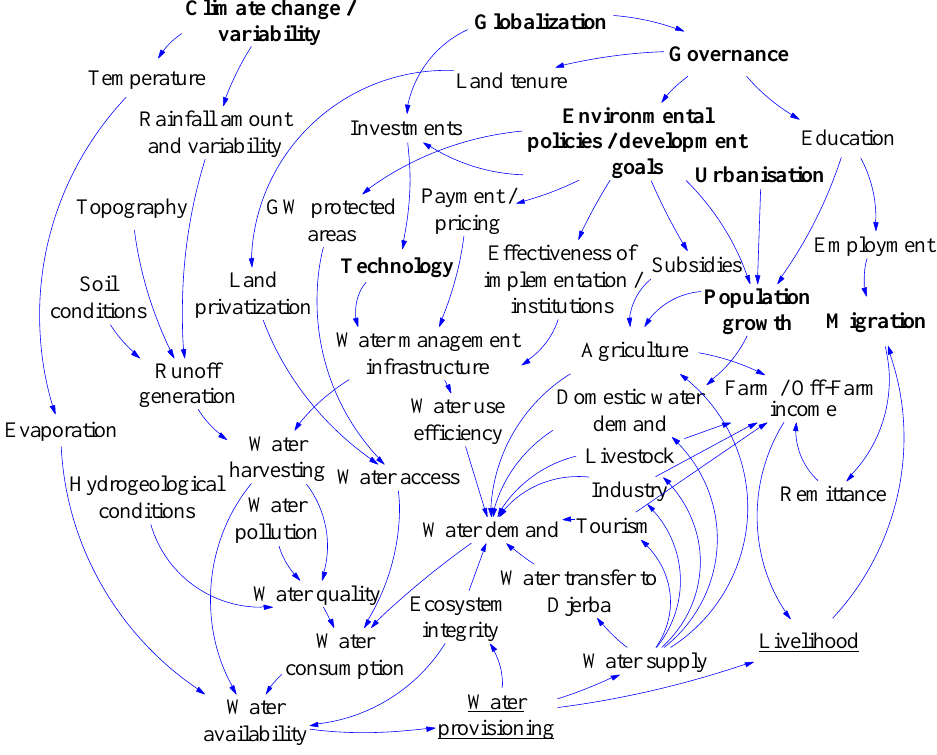
Figure A2.1: Concept map developed by the scenario team in Oum Zessar based on the focal issue: How to preserve and manage the water resources and the socio-agro-ecological system for sustainable development? The main drivers selected by the scenario team are in bold and the indicators for the impact assessment are